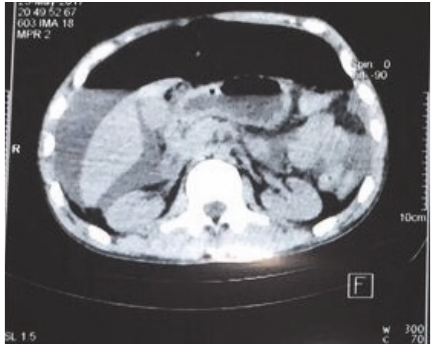
Figure 2: Longitudinal image of the left upper quadrant. Fluid can be seen not only surrounding the spleen, but also superior to the diaphragm on the far left of the image.